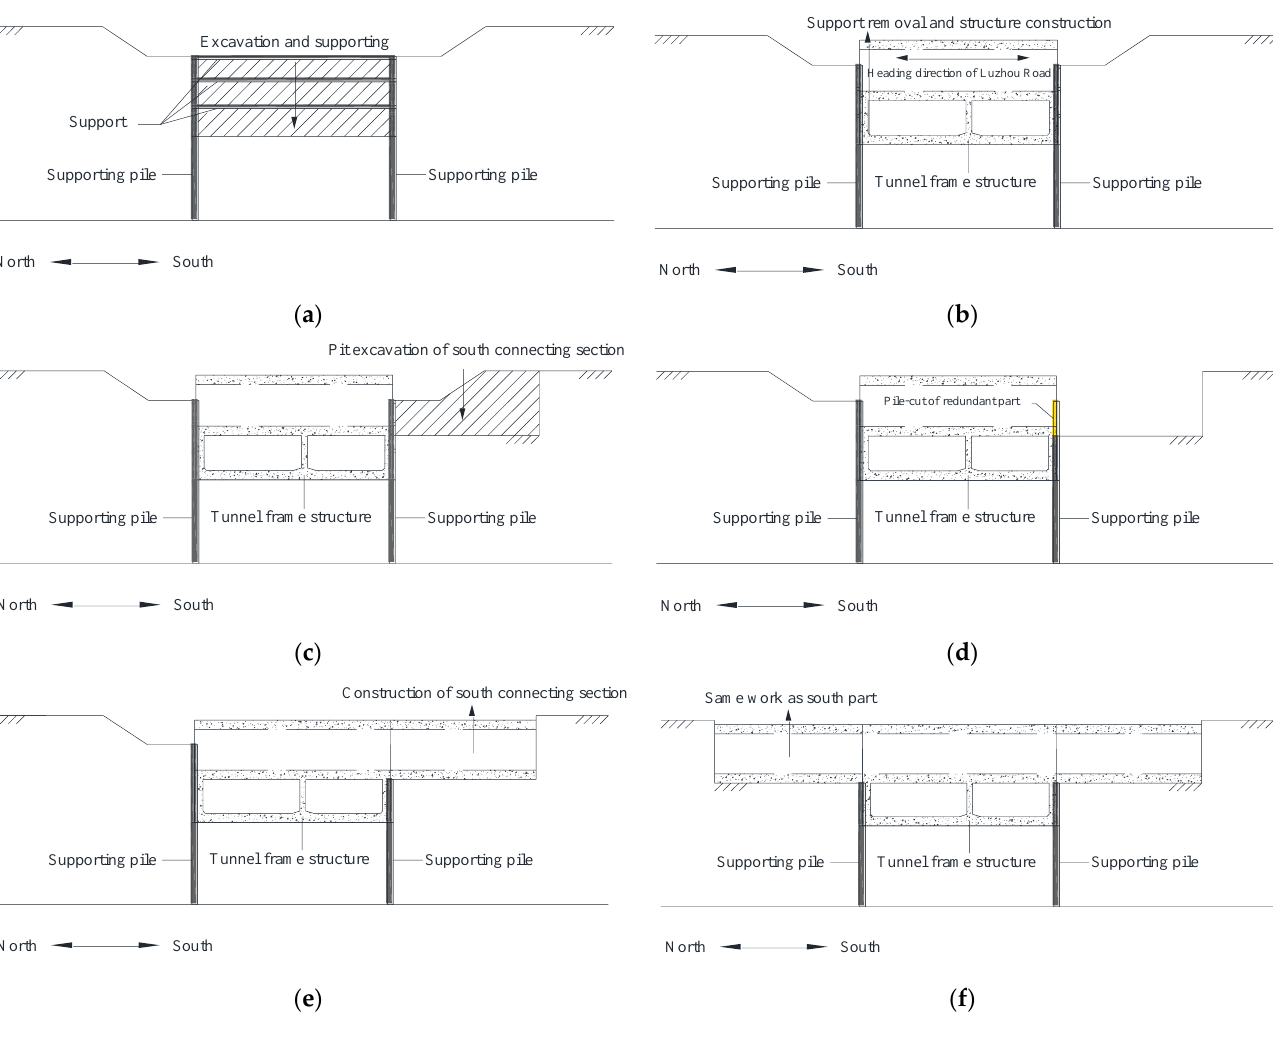
Figure 3. Construction process of connecting section: ( a ) pit excavation with supporting pile in Huayuan Road; ( b ) construction of frame structure in Huayuan Road; ( c ) excavation of pit in southern connecting part; ( d ) supporting pile cutting; ( e ) construction of southern connecting frame structure and ( f ) construction of northern connecting frame structure.